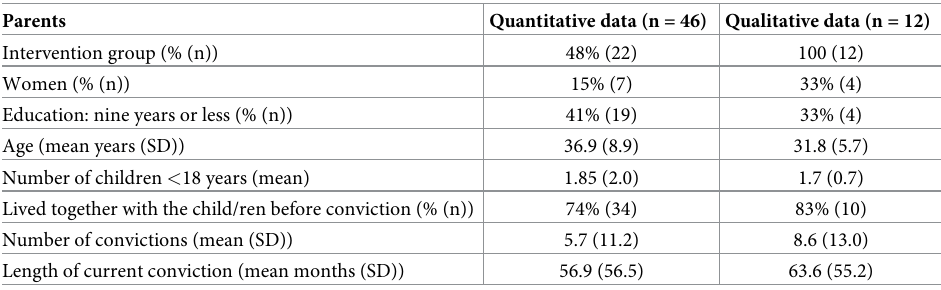
Table 1. Characteristics of